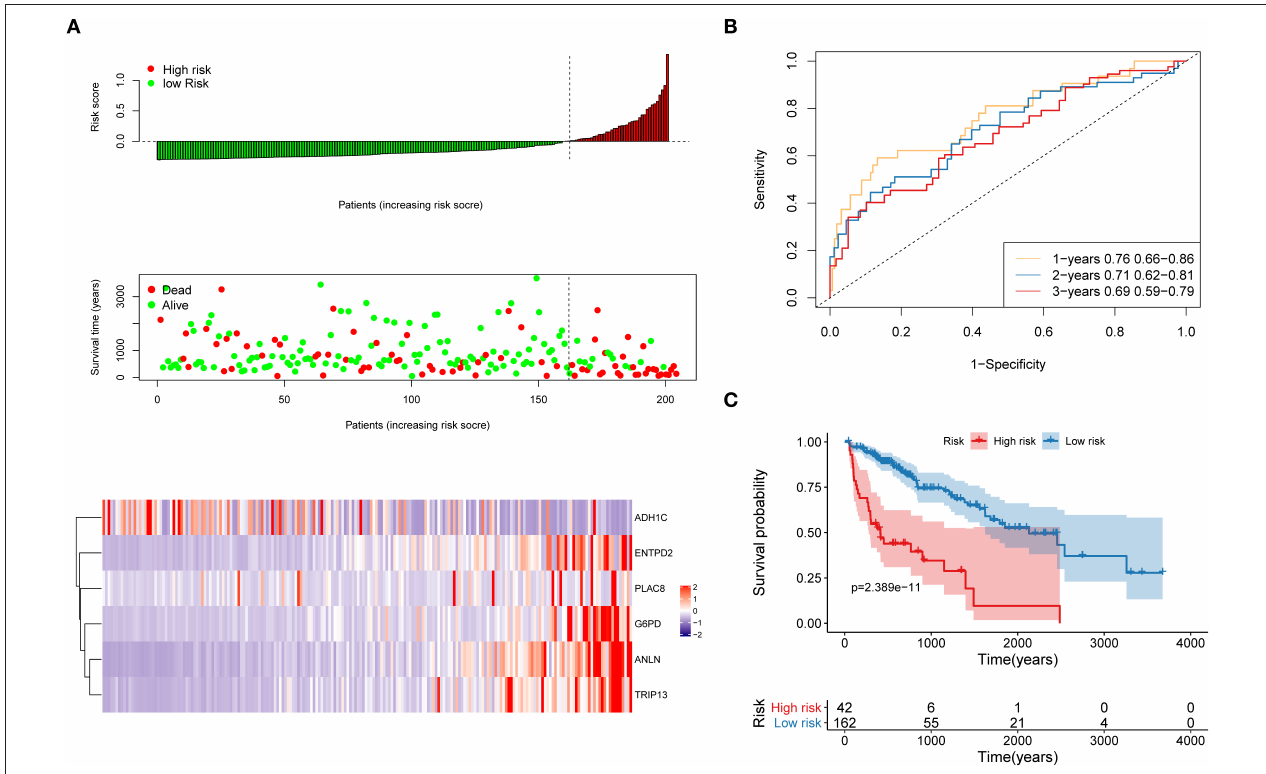
FIGURE 5 | Evaluation of the performance of the risk model in the training cohort. (A) Distribution of risk score, OS, survival status (red dots indicate death, blue dots indicate alive) and the six genes expression heat map in the training cohort; (B) ROC curves and area under the curve (AUC) for 1-, 2-, and 3-year survival in the training cohort of the risk model; (C) Kaplan–Meier (KM) curves of the OS in the training cohort.